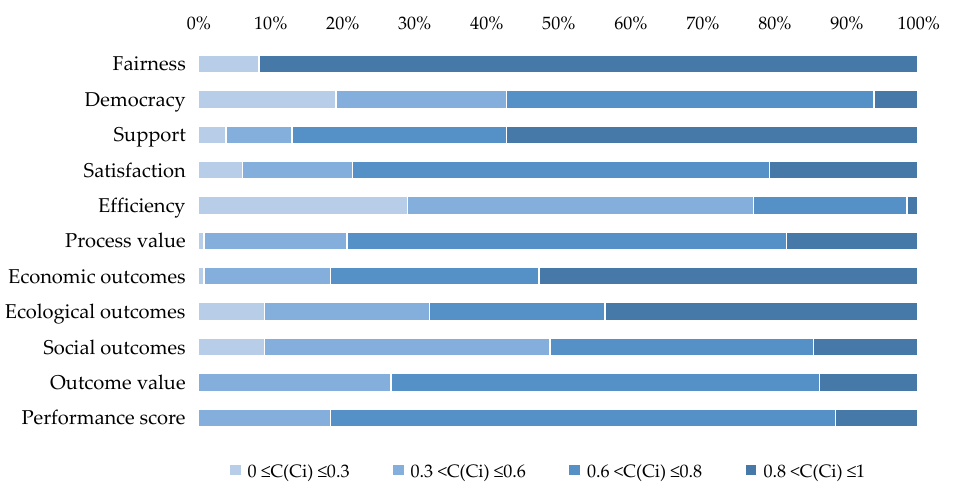
Figure 7. Distribution of performance value of ERP in different intervals. Note: Ci indicates the average closeness of each component; C indicates the average closeness of performance value of ERP.